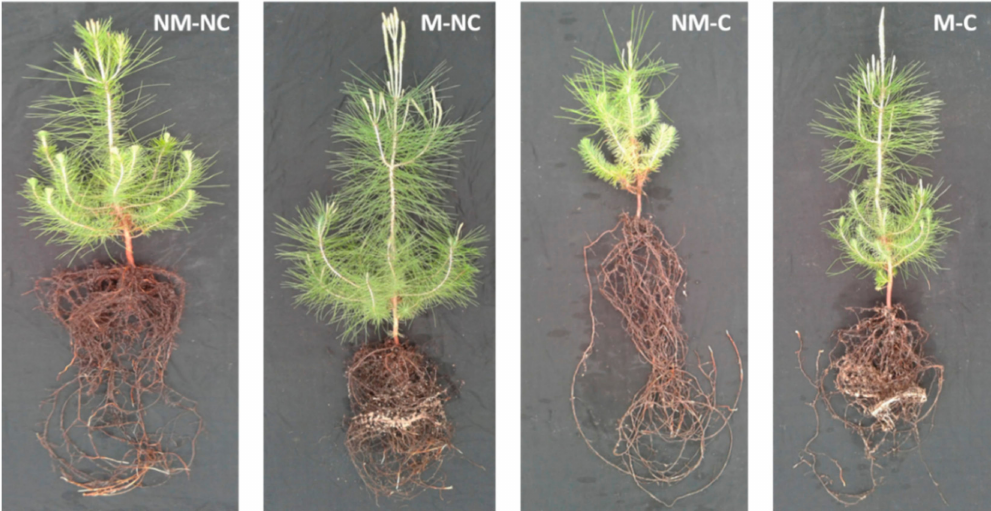
Figure 1. Morphological aspects of ectomycorrhizal (M) and non-ectomycorrhizal (NM) Pinus halepensis seedlings after 12 months of growth in contaminated (C) and control soil (NC).